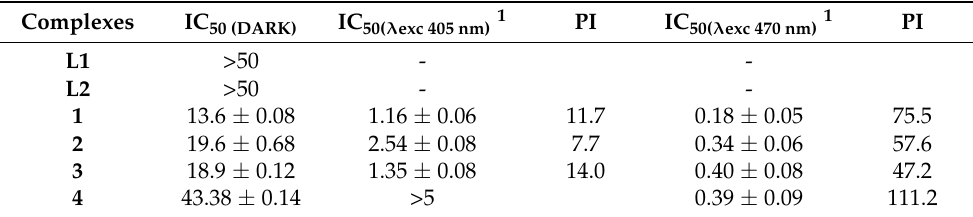
Table 2. IC 50 values of complexes 1 – 4 and L1 – L2 incubated for 24 h in A549 cells. Complexes